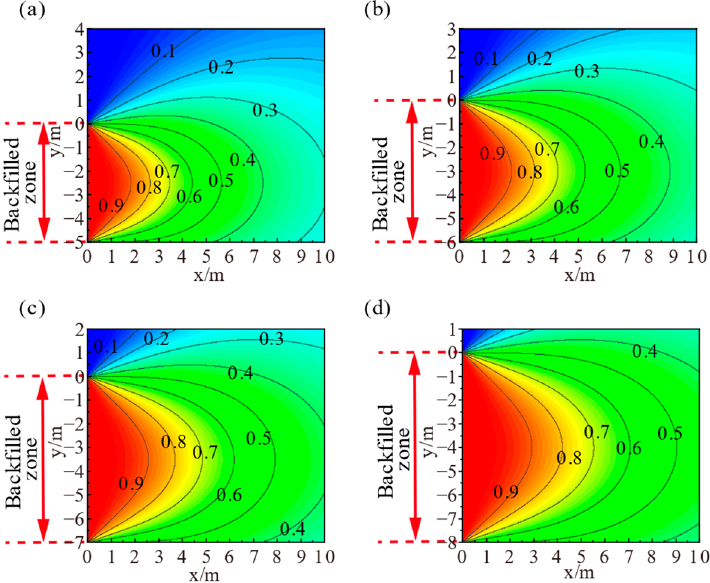
Figure 8. Contours of additional stress distribution in coal with different backfill body heights. ( a ) 5 m, ( b ) 6 m, ( c ) 7 m, ( d ) 8 m.